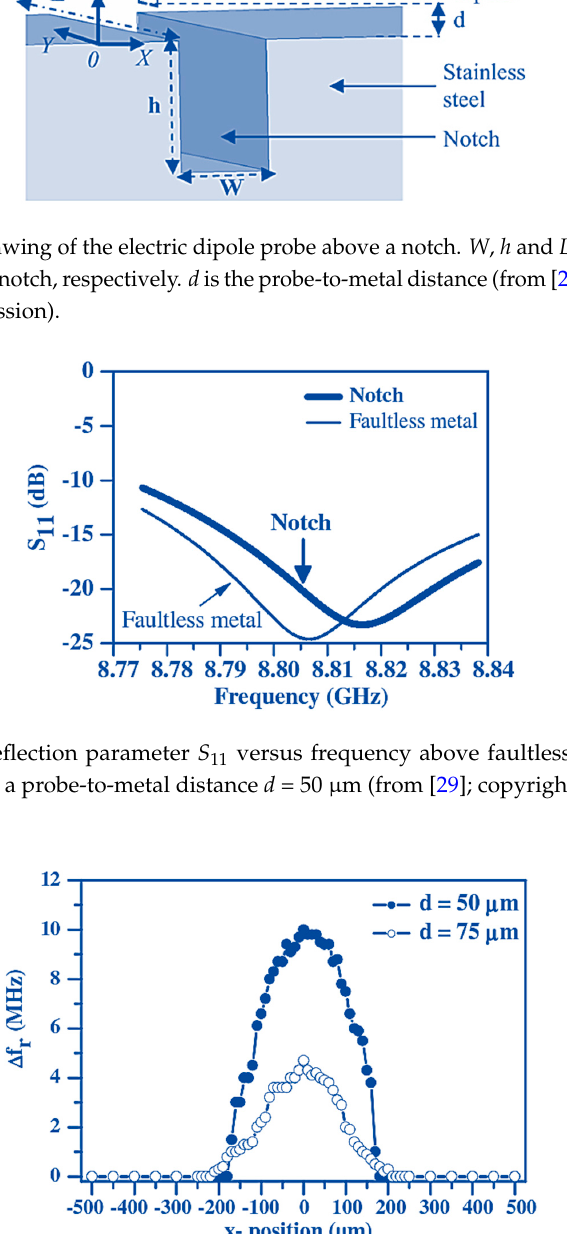
Figure 6. 1D scans ( x direction) above a stainless steel plate with a 200 ‐μ m ‐ wide notch measured with the electric dipole probe for probe ‐ to ‐ metal distances d of 50 and 75 μ m, respectively. Variations of the resonance frequency ( ∆ f r ) as a function of the x ‐ position; x = 0 corresponds to the middle of the notch (from [29]; copyright © 2008; redesigned with